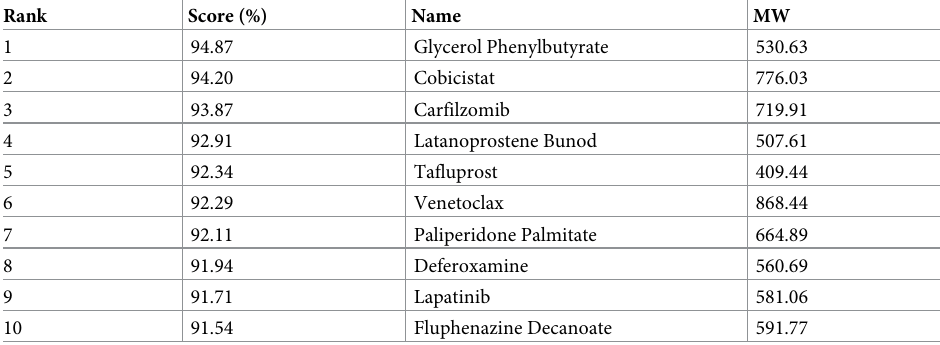
Table 1. Top 10 hits from the PLANTS virtual structure-based screen of e-Drug3D library of FDA approved drugs against the GBS BspC V-domain. Rank Score